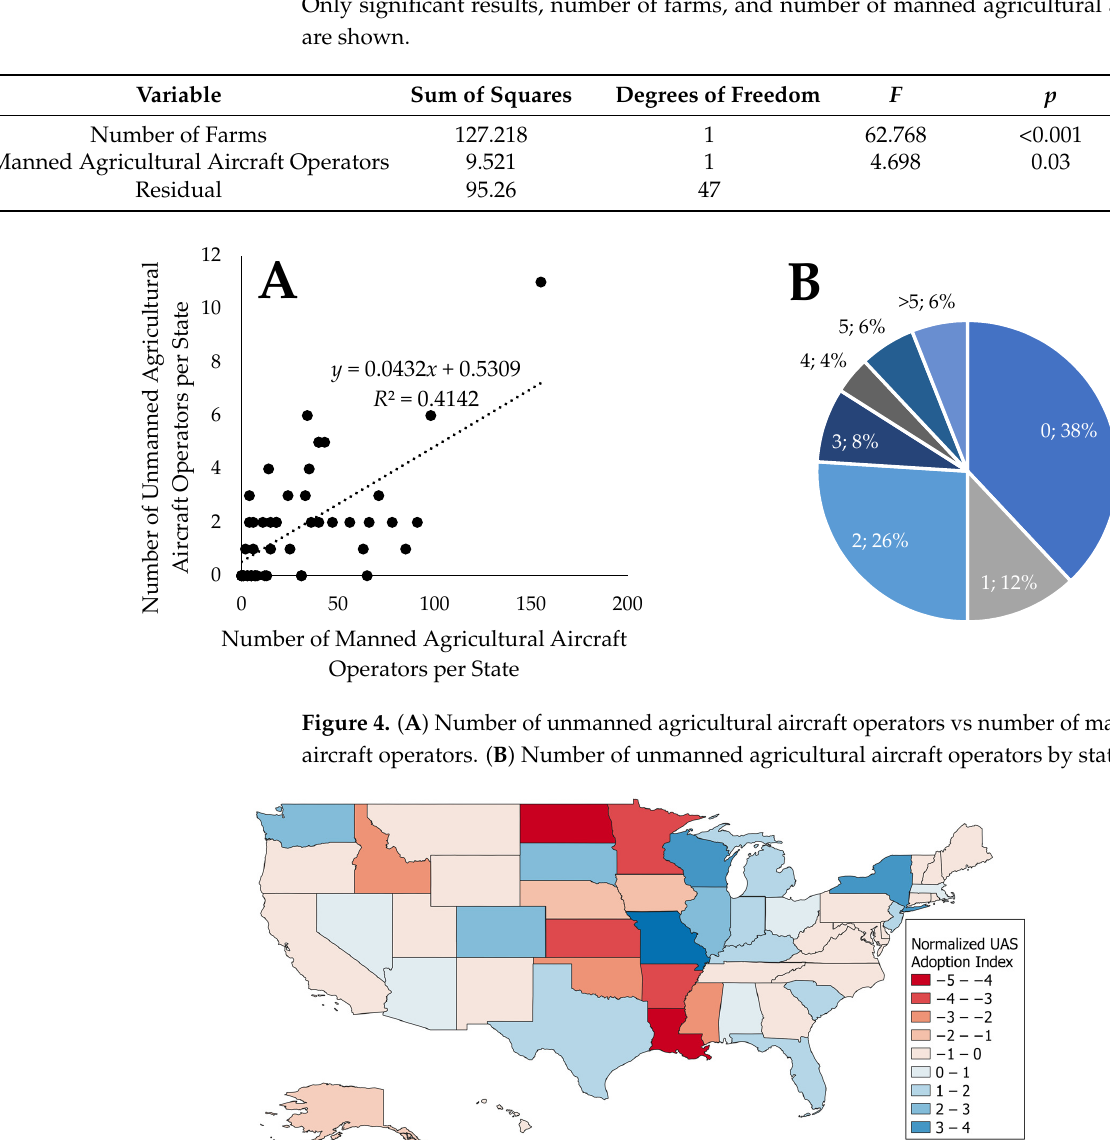
Table 1. Results of statistical analysis of factors affecting number of UAS agricultural aircraft operators.